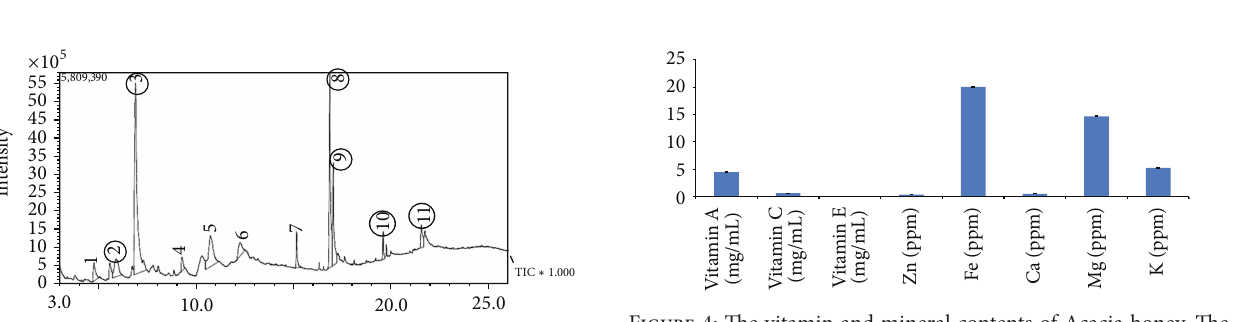
Figure 4: The vitamin and mineral contents of Acacia honey. The mineral element contents of Acacia honey. Values are presented as mean ±